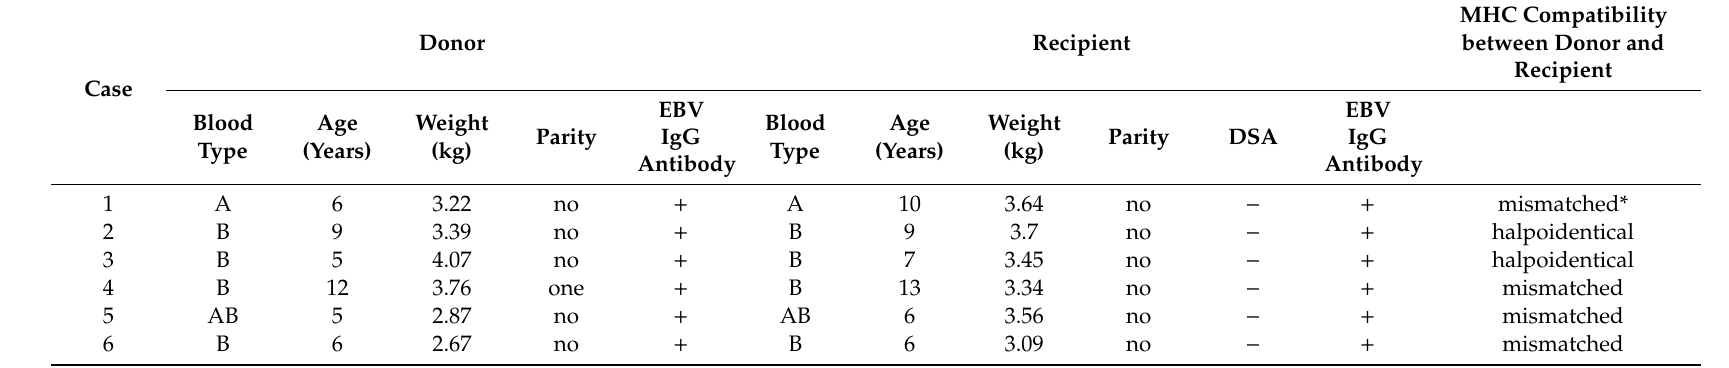
Table 1. Pretransplant characteristics of the study